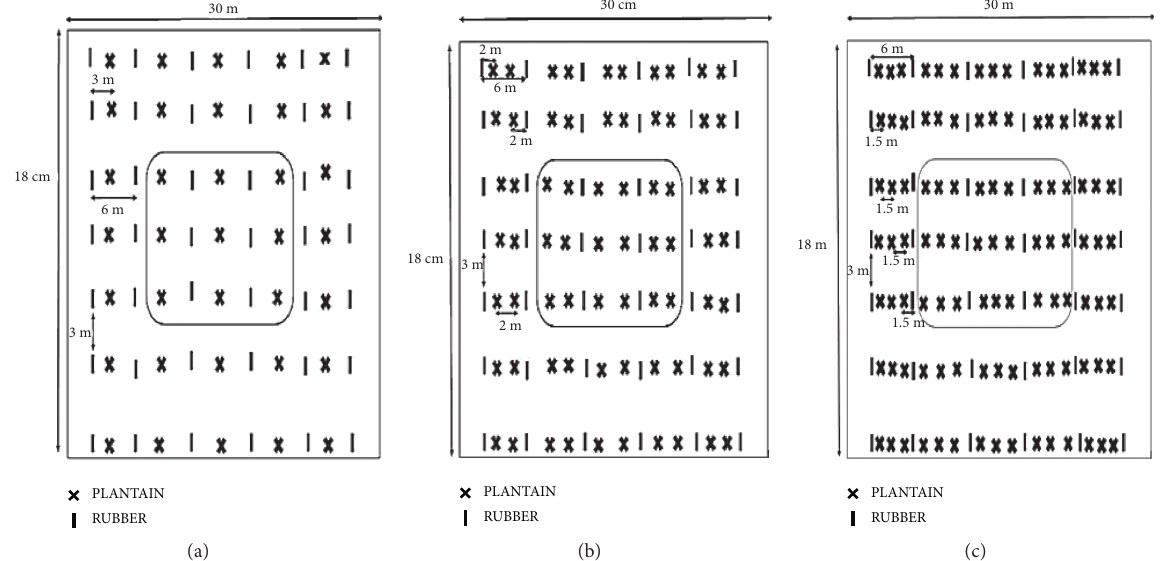
Figure 4: Population of plantain within the rubber-plantain intercropping systems: the marked plants were the selected plants for measurements in each treatment. (a) One row of plantain: two rows of rubber. (b) Two rows of plantain: two rows of rubber. (c) Three rows plantain: two rows of